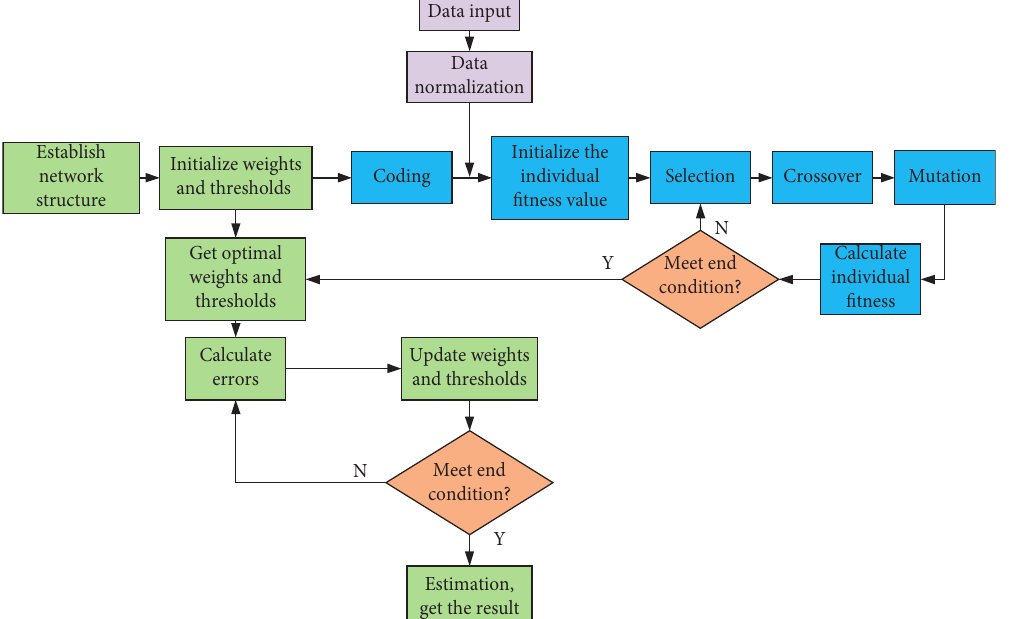
i has been altered.